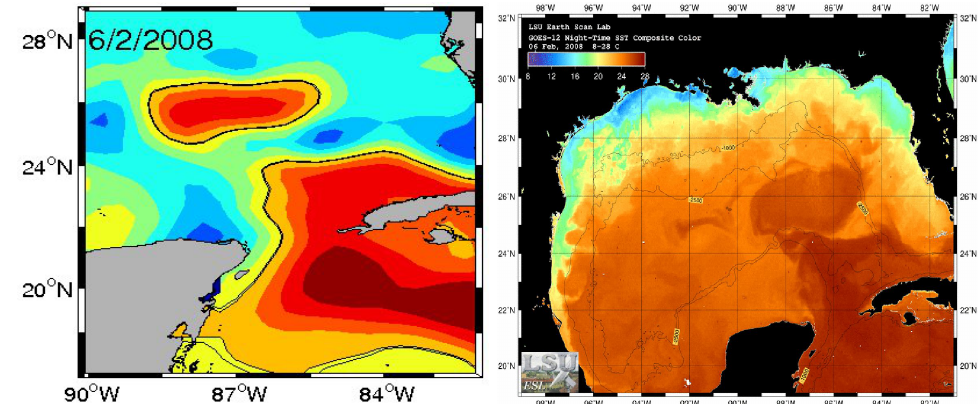
Fig. 1. Weekly snapshot of SSH from AVISO (Archiving, validation and interpretation of satellite oceanographic data) (a) , and SST from GOES (Geostationary Operational Environmental Satellite) SST composite produced by Louisiana State University (b) , for 6 February 2008. Fig. 01. Weekly snapshot of SSH from AVISO (Panel a), and SST from GOES SST composite produced by Louissiana State University Notice the 17-SSH contour (black line) suggests the Loop Current eddy (LCE) has already detached from the LC whereas the SST composite indicates the LCE is still (Panel b), for Feb. 6, 2008. Notice the 17 − SSH contour (black line) suggests the Loop Current Eddy (LCE) has already dettached from the LC whereas the SST composite indicates the LCE is still attached